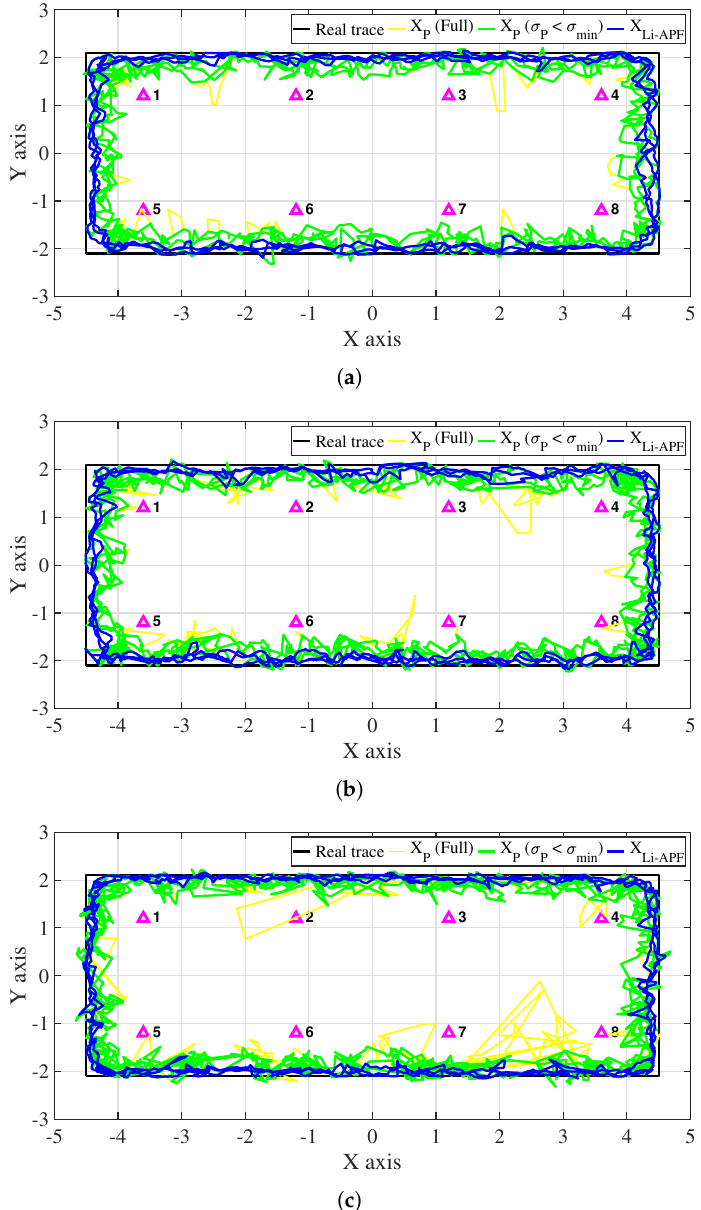
( c ) Figure 12. Experimental results in classroom environment: ( a ) Pose 1; ( b ) Pose 2; ( c ) Pose